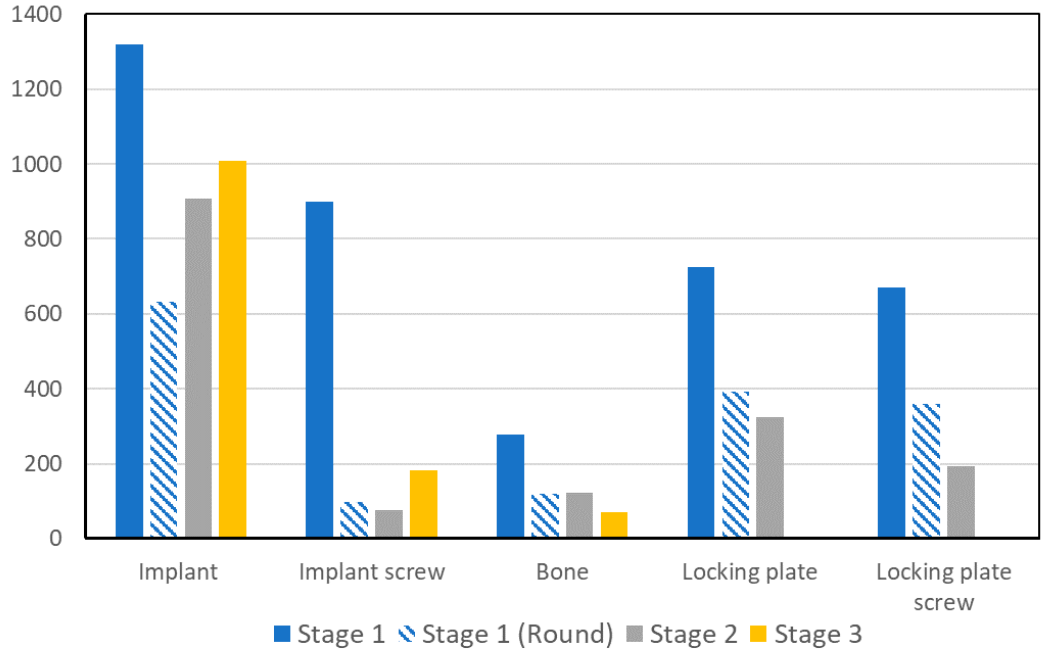
Figure 4. The result of FE analysis for the von Mises stresses for implant, implant screw, locking plate and locking screw at different simulated stages. The value decreased by half after we introduced the rounded angle design into the implant.